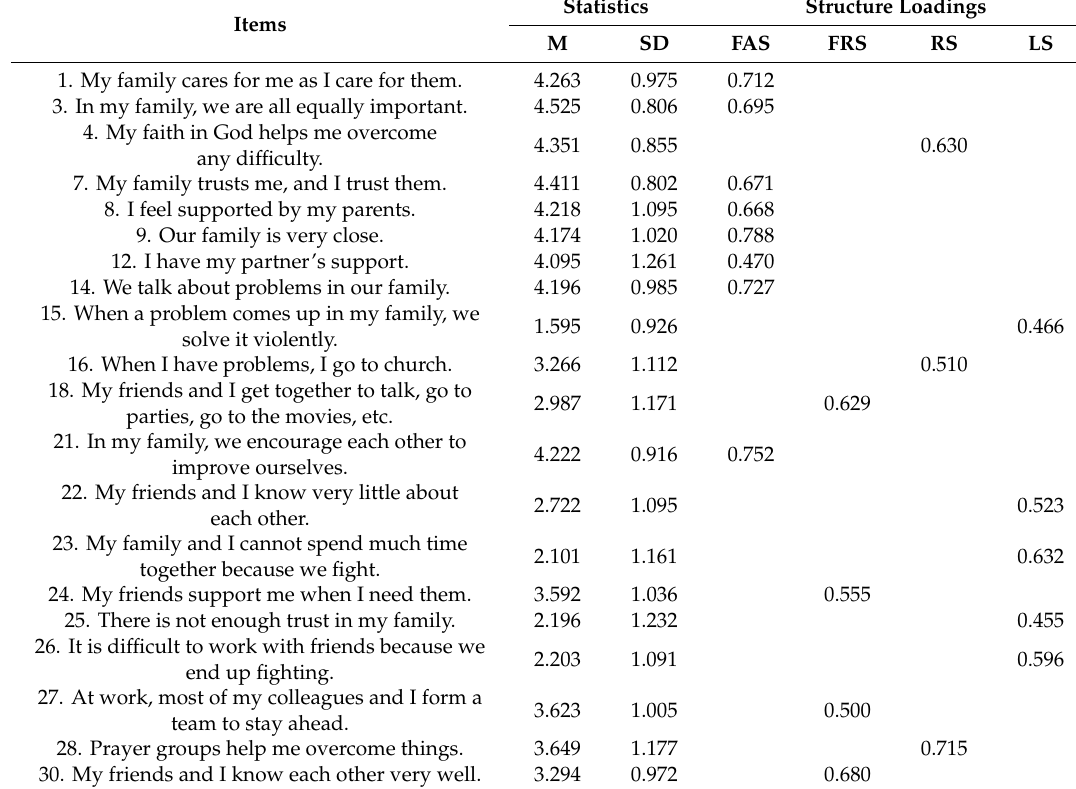
Table 4. Descriptive statistics and structure loadings of